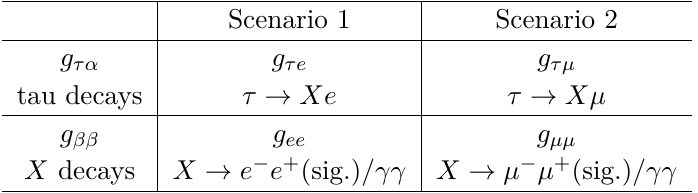
Table 1 . Summary of the basic features of the two benchmark scenarios studied in this work, including the couplings switched on and the corresponding induced decays of τ and X . “Sig.” indicates the signature